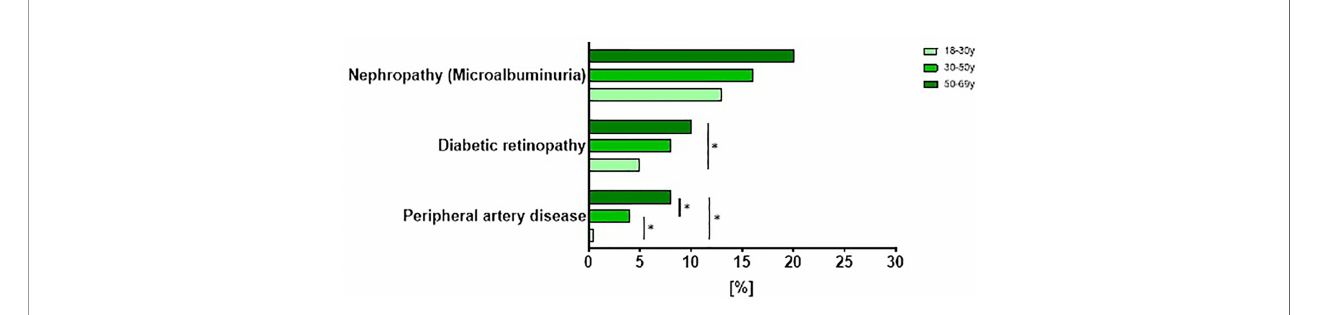
FIGURE 8 | Prevalence of diabetes related complications in patients with newly diagnosed type 1 diabetes strati fi ed by age. Prevalence of diabetes-related complications strati fi ed by age tertiles in participants with newly diagnosed type 1 diabetes from the GDS and DPV cohort. Data are expressed as percent from the total number of measured participants in each cohort. *p < 0.05 regarding the prevalence of complications adjusted for age, sex, BMI, migration background, hypertension